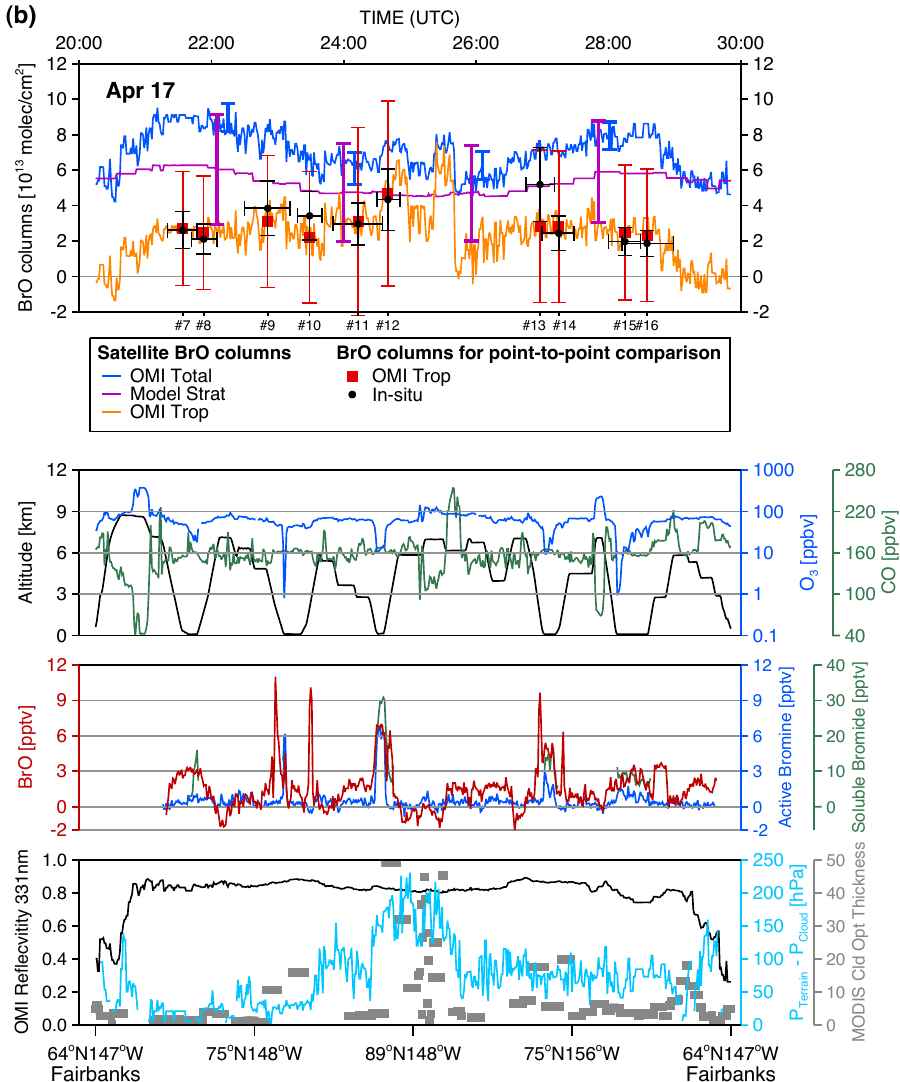
Fig. 6b. Time series plots for NASA ARCTAS DC-8 flight of 17 April 2008. For bottom three panels, line colors corresponding to the same color y axis. The top panel shows various estimates of VCD of BrO along the DC-8 flight track, including OMI total column, the modeled stratospheric column, and tropospheric columns based on aircraft in-situ measurements (black dots) as well as our analysis of OMI retrievals (red squares). The error bars of the tropospheric columns are described in the text. The two middle panels show various aircraft in-situ measurements along with the flight altitude. The bottom panel shows OMI reflectivity at 331nm and cloud retrieved parameters from OMI and MODIS, as described in the text. Soluble bromide is not plotted when the reported mixing ratio was below the detection limit (1–6pptv).